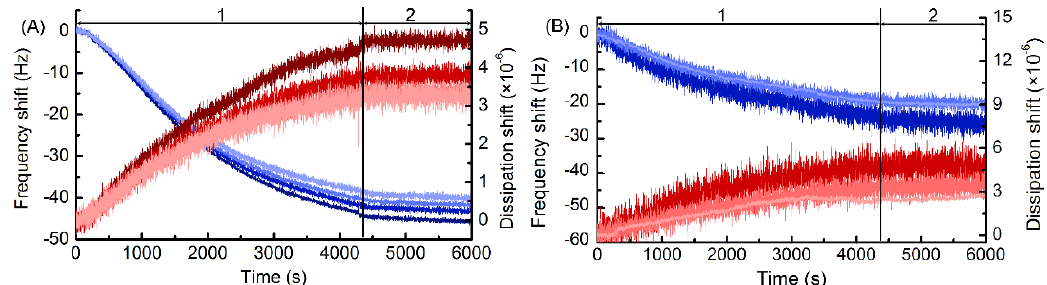
Figure 6. Frequency and dissipation shifts, in response to methylene blue attachment to ( A ) the quartz crystal microbalance with dissipation monitoring sensor coated with the molecularly imprinted polymer and ( B ) the quartz crystal microbalance with dissipation monitoring sensor coated with the non-imprinted polymer. 1 indicates the introduction of methylene blue and 2 indicates rinsing with water.